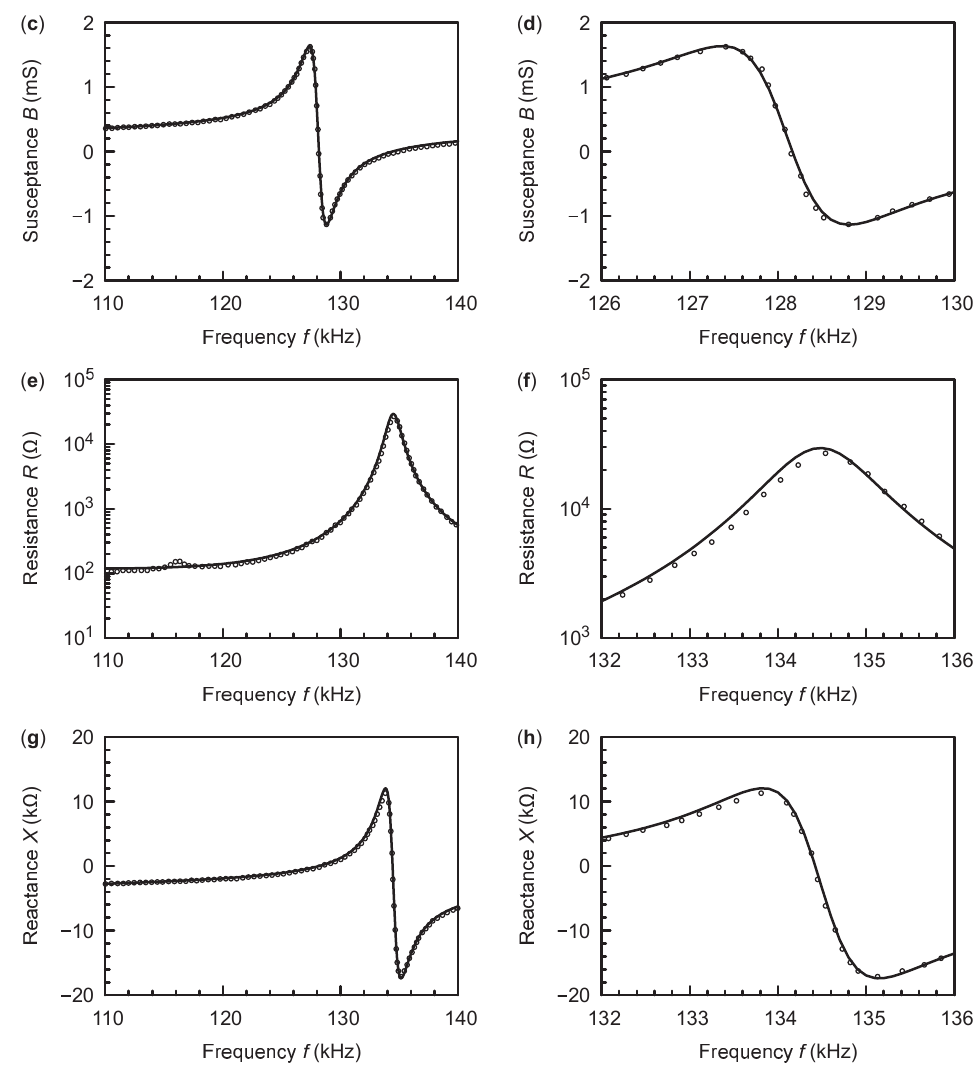
Figure 2. The measured and best fitting admittance and impedance of the soft PZT. ( a , b ) Conductance. ( c , d ) Susceptance. ( e , f ) Resistance. ( g , h ) Reactance. ( b , d , f , h ) are the close-up views of ( a , c , e , g ), respectively.